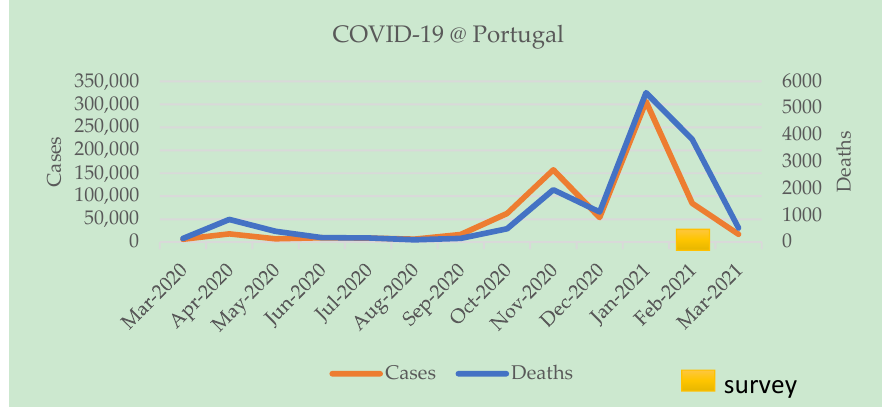
Figure 1. COVID ‐ 19 cases and deaths, Portugal, and the survey moment. Figure 1. COVID-19 cases and deaths, Portugal, and the survey